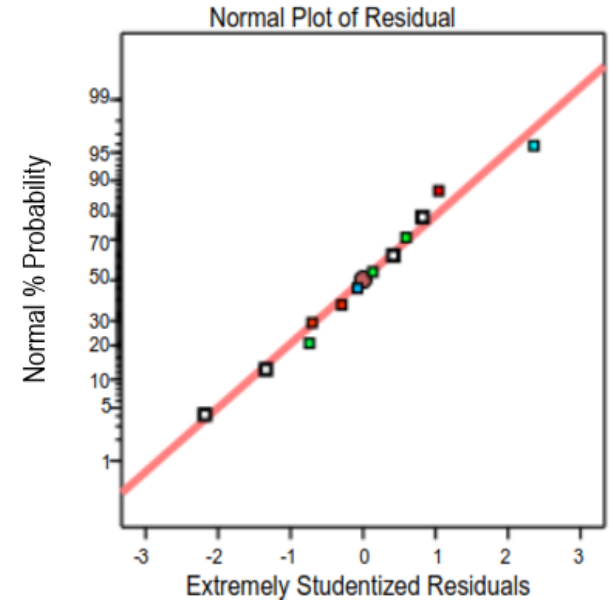
Figure 1. Data analysis for the normal plot of residuals.